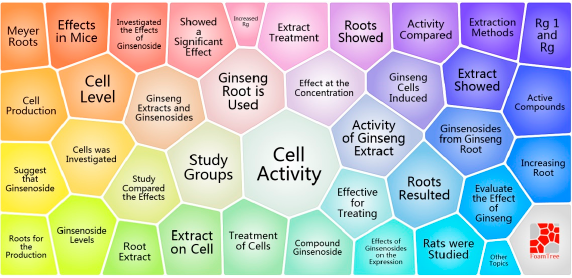
Figure 6. A visual survey of major topics on P. ginseng generated by the Carrot system.